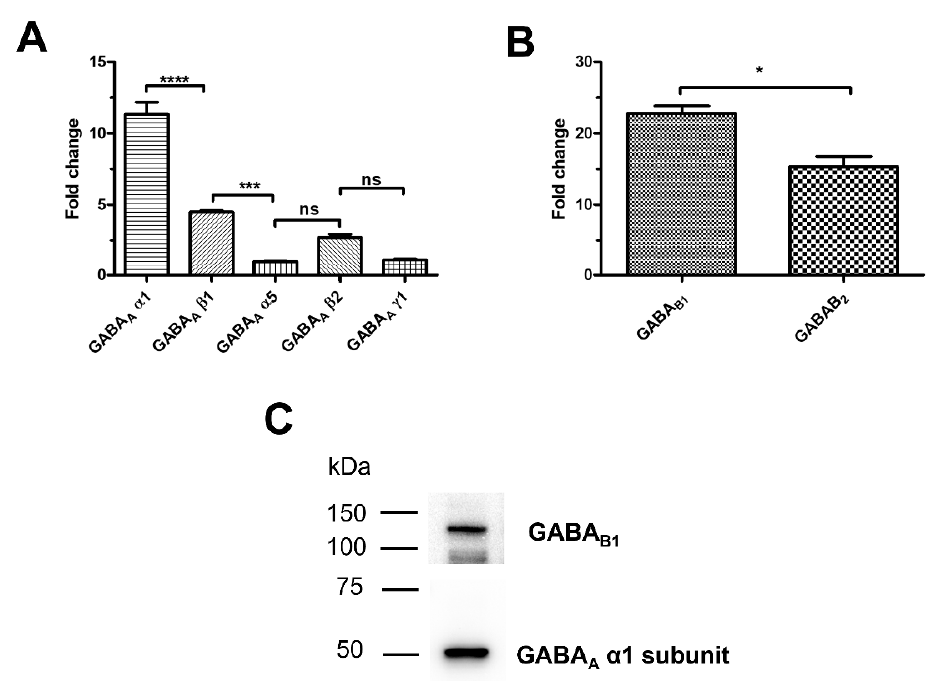
Figure 1. GABA A and GABA B receptors are expressed in hCMEC/D3 cells. ( A ), a panel of GABA A receptor subunit transcripts are expressed in hCMEC/D3 cells based on qRT-PCR data. **** indicate p < 0.0001 *** indicate p < 0.001 (One-way ANOVA followed by the post-hoc Bonferroni test). NS indicates not significant. ( B ), both GABA B1 and GABA B2 receptor subunit transcripts are expressed in hCMEC/D3 cells. * indicates p < 0.05 (Student’s t -test). ( C ), representative immunoblots showing that both GABA A α 1 and GABA B1 subunits are expressed at protein level. qRT-PCR and immunoblotting analyses were carried out on three distinct biological